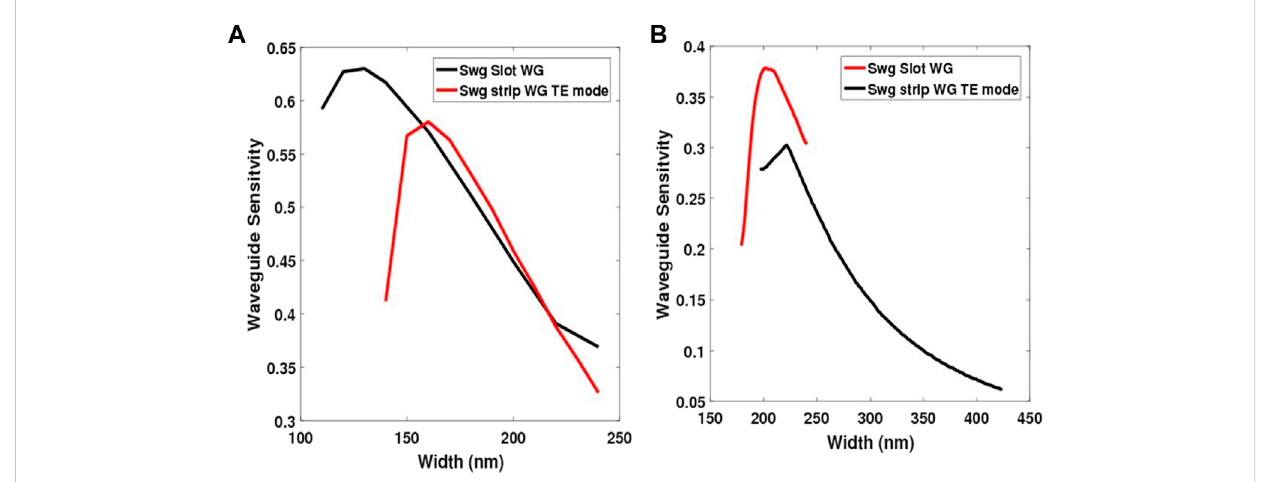
FIGURE 3 (A) Waveguide sensitivity of both strip and slot waveguides as a function of their widths for water cladding. (B) The same but for air